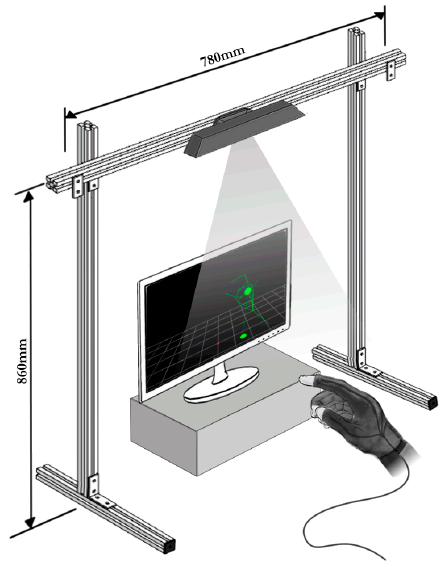
Figure 1. Schematic representation of the test setup.